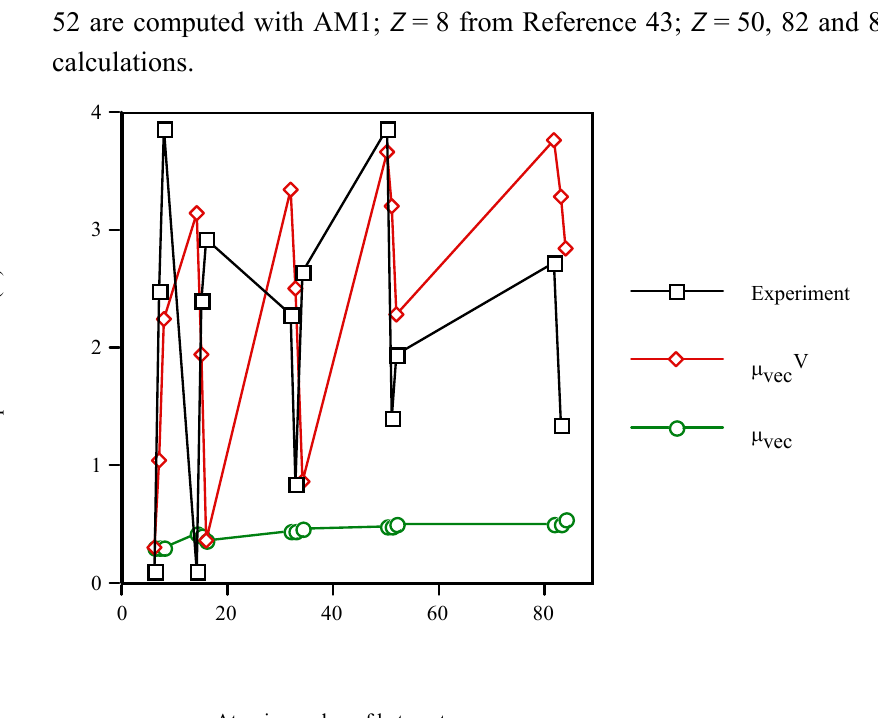
Figure 2. Dipole moment of the valence-isolectronic series of styrene vs . the atomic number of the heteroatom. Point with Z = 6 from Reference 42; Z = 7, 14–16, 32–34, 51 and 52 are computed with AM1; Z = 8 from Reference 43; Z = 50, 82 and 83 are PM3